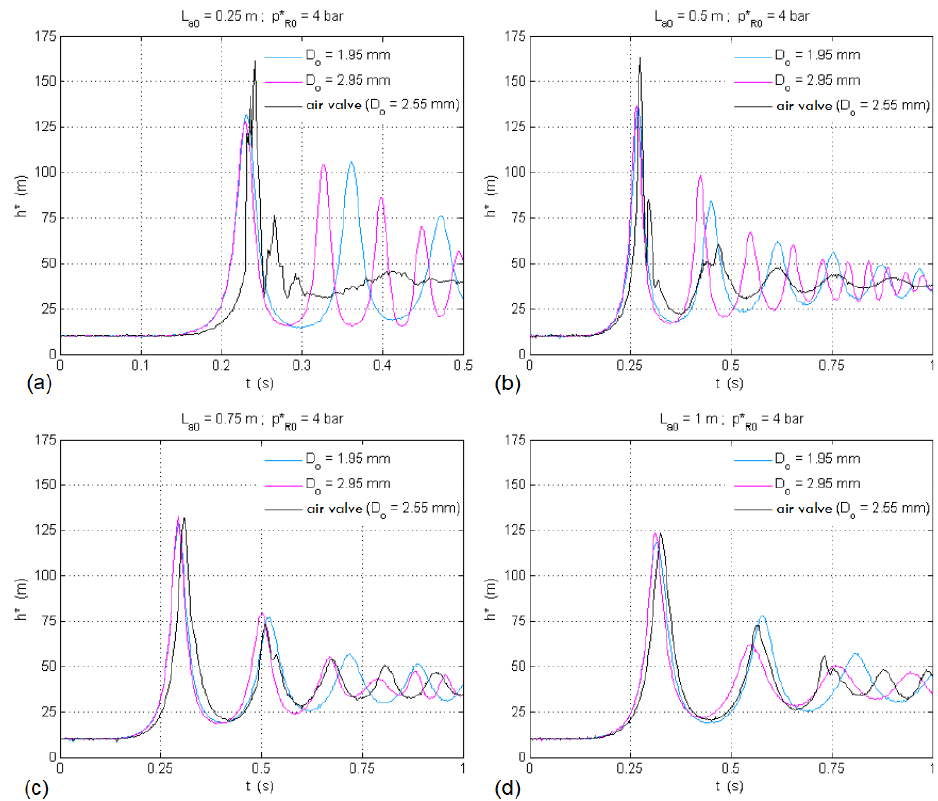
Figure 7. Influence of air pocket length and orifice size on transient pressure oscillations during pipeline filling: ( a ) L a 0 = 0.25 m; ( b ) L a 0 = 0.50 m; ( c ) L a 0 = 0.75 m; ( d ) L a 0 = 1.0